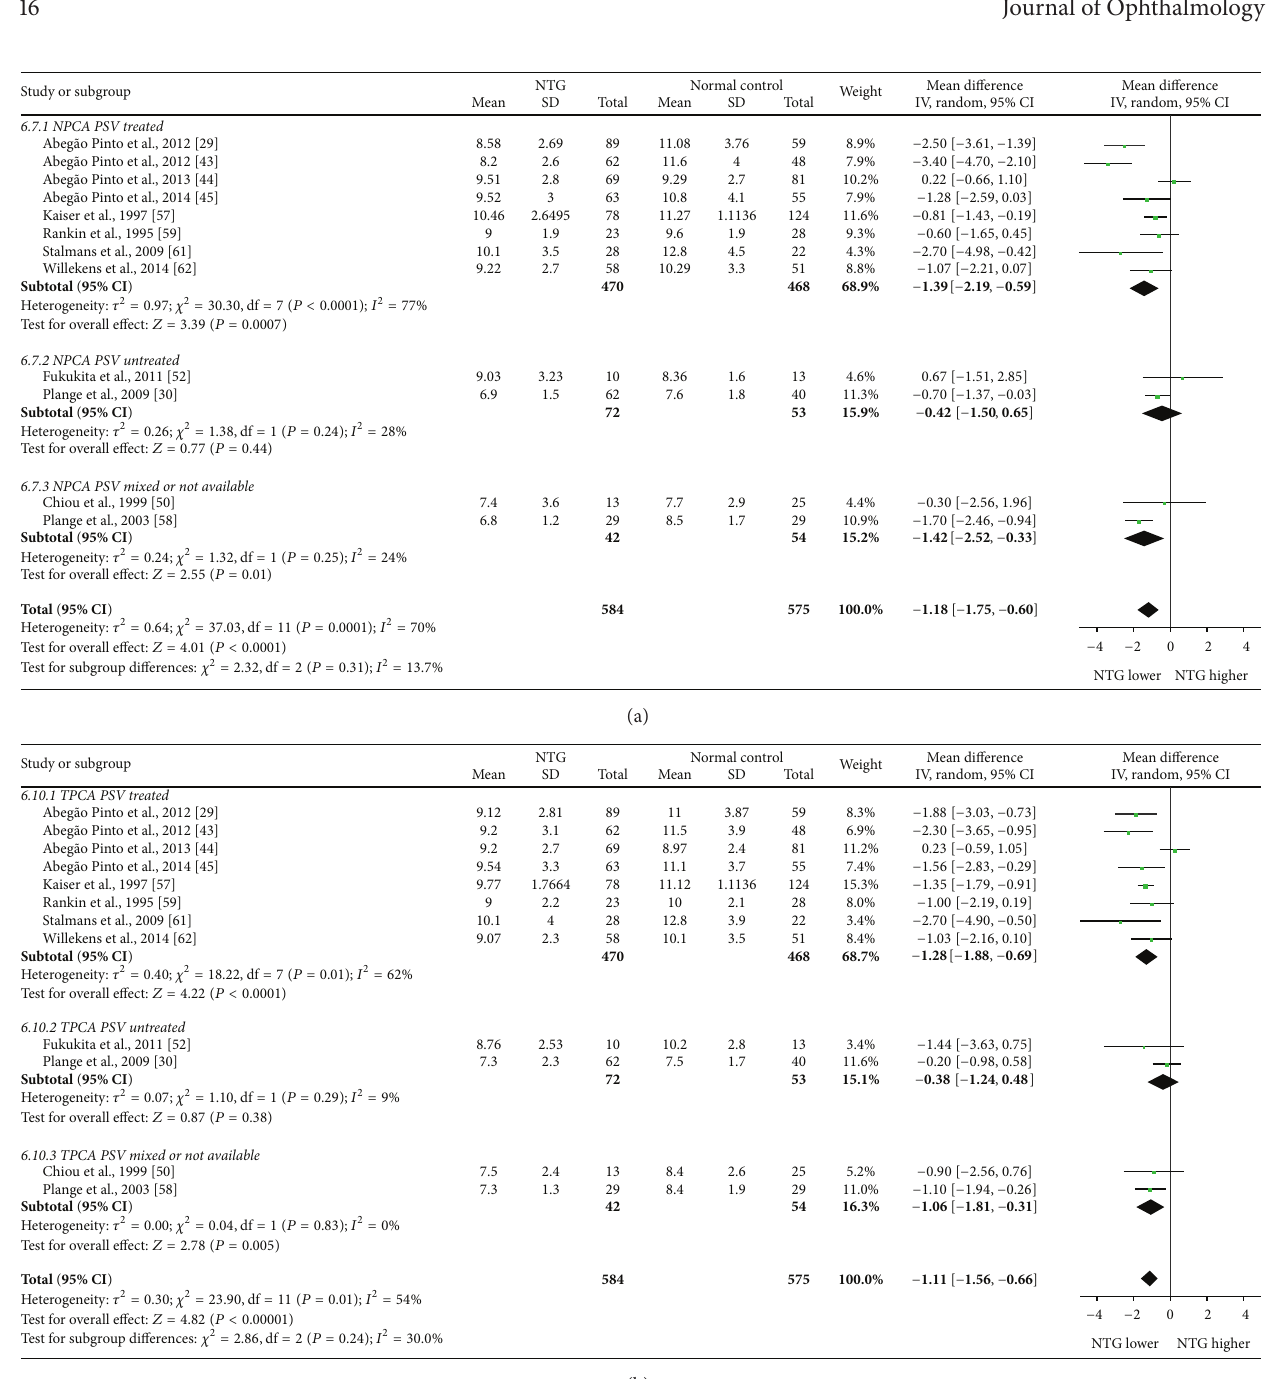
Figure 5: Forest plot of PSV in NPCA and